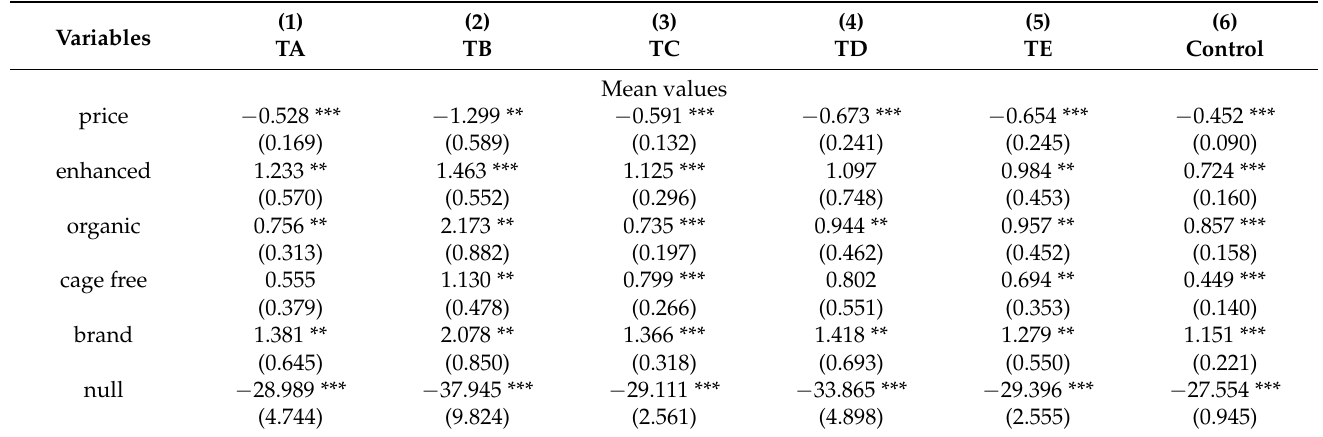
Table 4. Estimation results of the mixed logit model, by treatment.